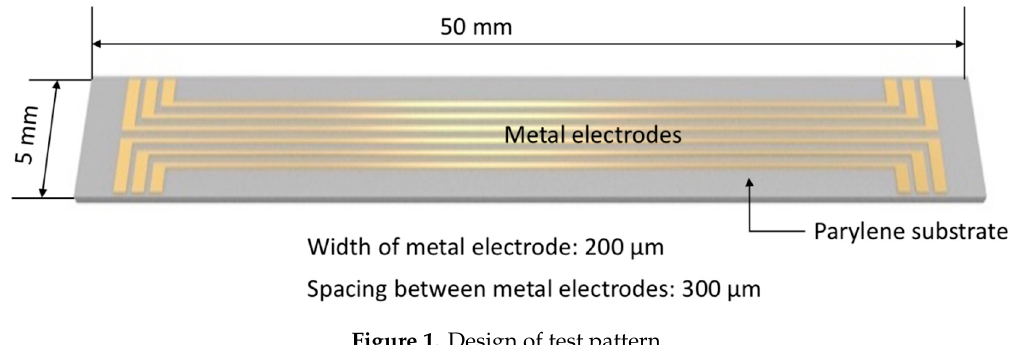
Figure 1. Design of test pattern.